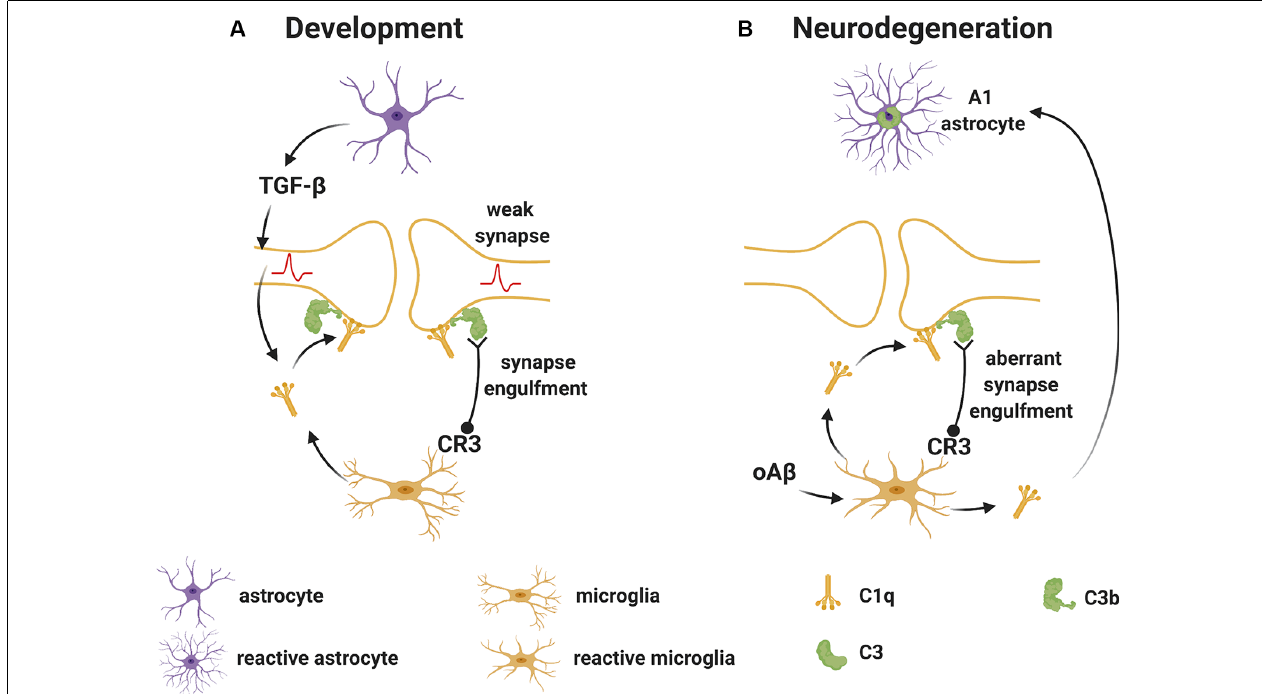
FIGURE 2 | Complement-mediated synapse elimination during development and in neurodegenerative diseases. (A) In the developing brain, astrocytes produce TGF- β that promotes the production of C1q by neurons. Neuron-derived and microglia-derived C1q tags weak synapses activating the classical complement pathway which results in the cleavage of C3 with deposition of C3b at synapses. C3b-tagged synapses are then removed through phagocytosis by microglia expressing the complement receptor CR3. (B) In neurodegenerative diseases, such as Alzheimer’s disease (AD), oA β promotes the production of C1q by microglia. C1q-tagged synapses are then eliminated by microglia via the classical complement pathway as observed for synapses during development. Also, microglia-derived C1q (together with IL-1 α and TNF) induces a subtype of C3 + reactive astrocytes, termed A1 astrocytes, which are neurotoxic. Abbreviations: oA β , oligomeric amyloid β ; TGF β , transforming growth factor β ; IL, interleukin; TNF, tumor necrosis factor.